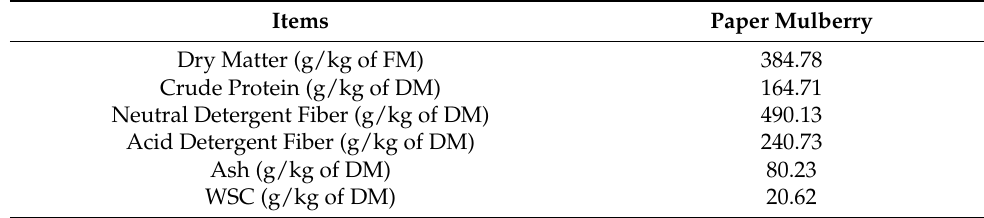
Table 1. Chemical composition of paper mulberry.